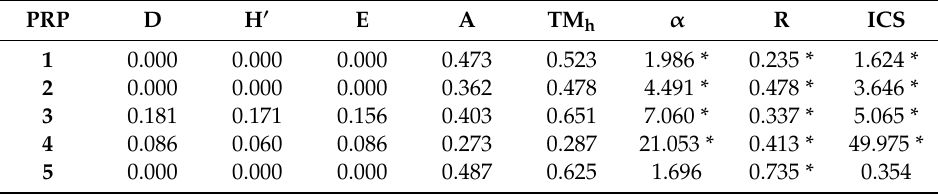
Figure 5. A histogram of the height frequencies of recruits according to tree species on permanent research plots (PRP) 1–5. Table 7. Biodiversity indices of natural regeneration on permanent research